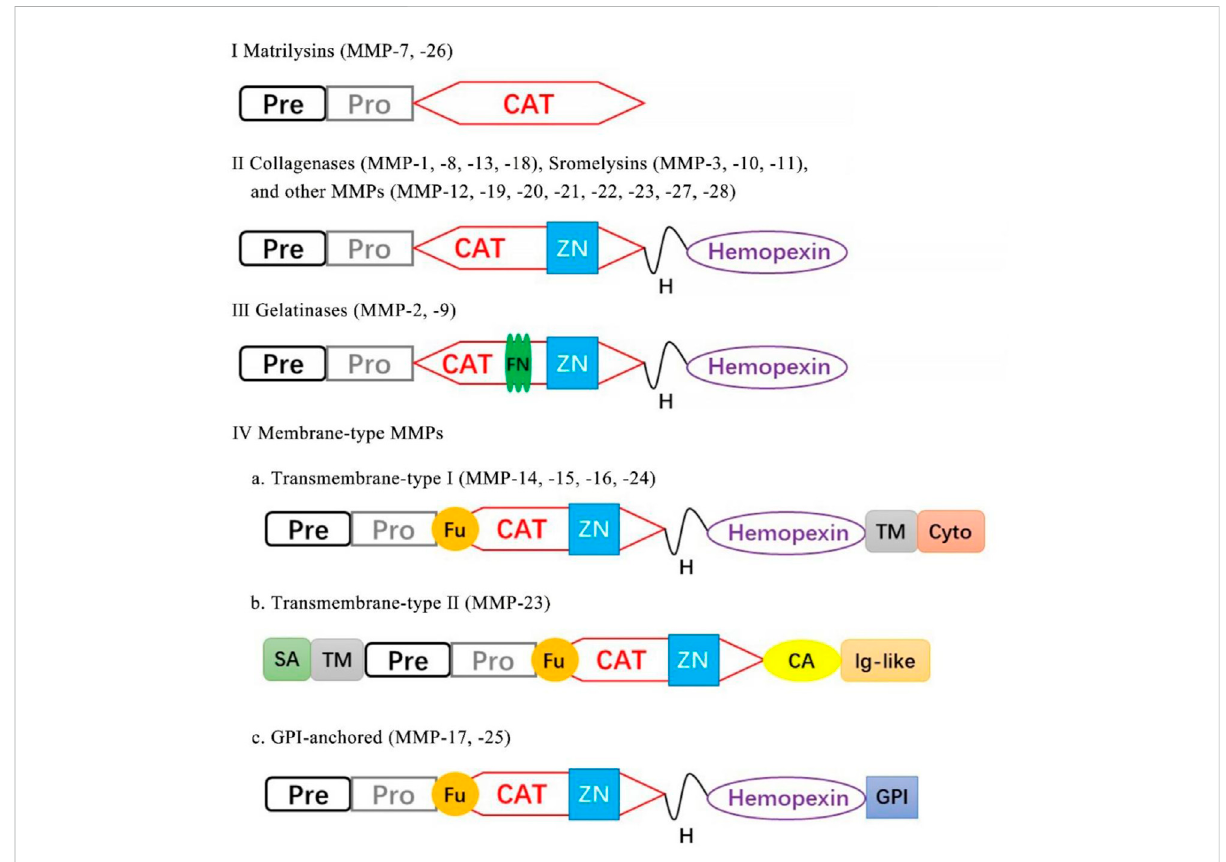
FIGURE 1 Classi fi cation of MMPs according to their domain structure. Pre, signal peptide; Pro, propeptide; CAT, catalytic; ZN, zinc-binding site; Fu, furin cleavage site; TM, transmembrane; Cy, cytoplasmic; SA, type-II signal anchor, H, hinge region; GPI, GPI anchor; FN, fi bronectin